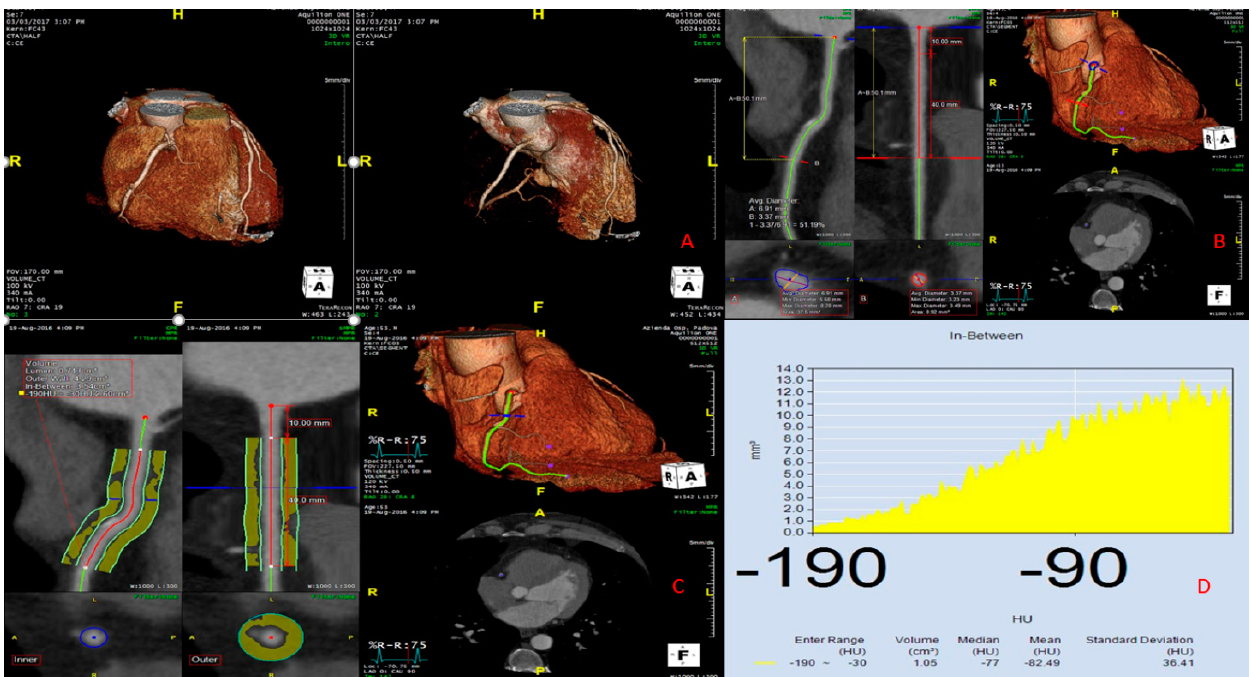
Figure 1. Example of how to measure the pericoronary adipose tissue. ( A ) Three-dimensional (3D) coronary CT recon- struction obtained using Aquarius TeraRecon. ( B ) Selection of the right coronary artery (RCA) and its region of interest using Aquarius TeraRecon. ( C ) Pericoronary tissue analysis showing the distribution of values between − 190 and − 30 HU. ( D ) Histogram showing the distribution of pericoronary tissue values in the range of − 190 and − 30